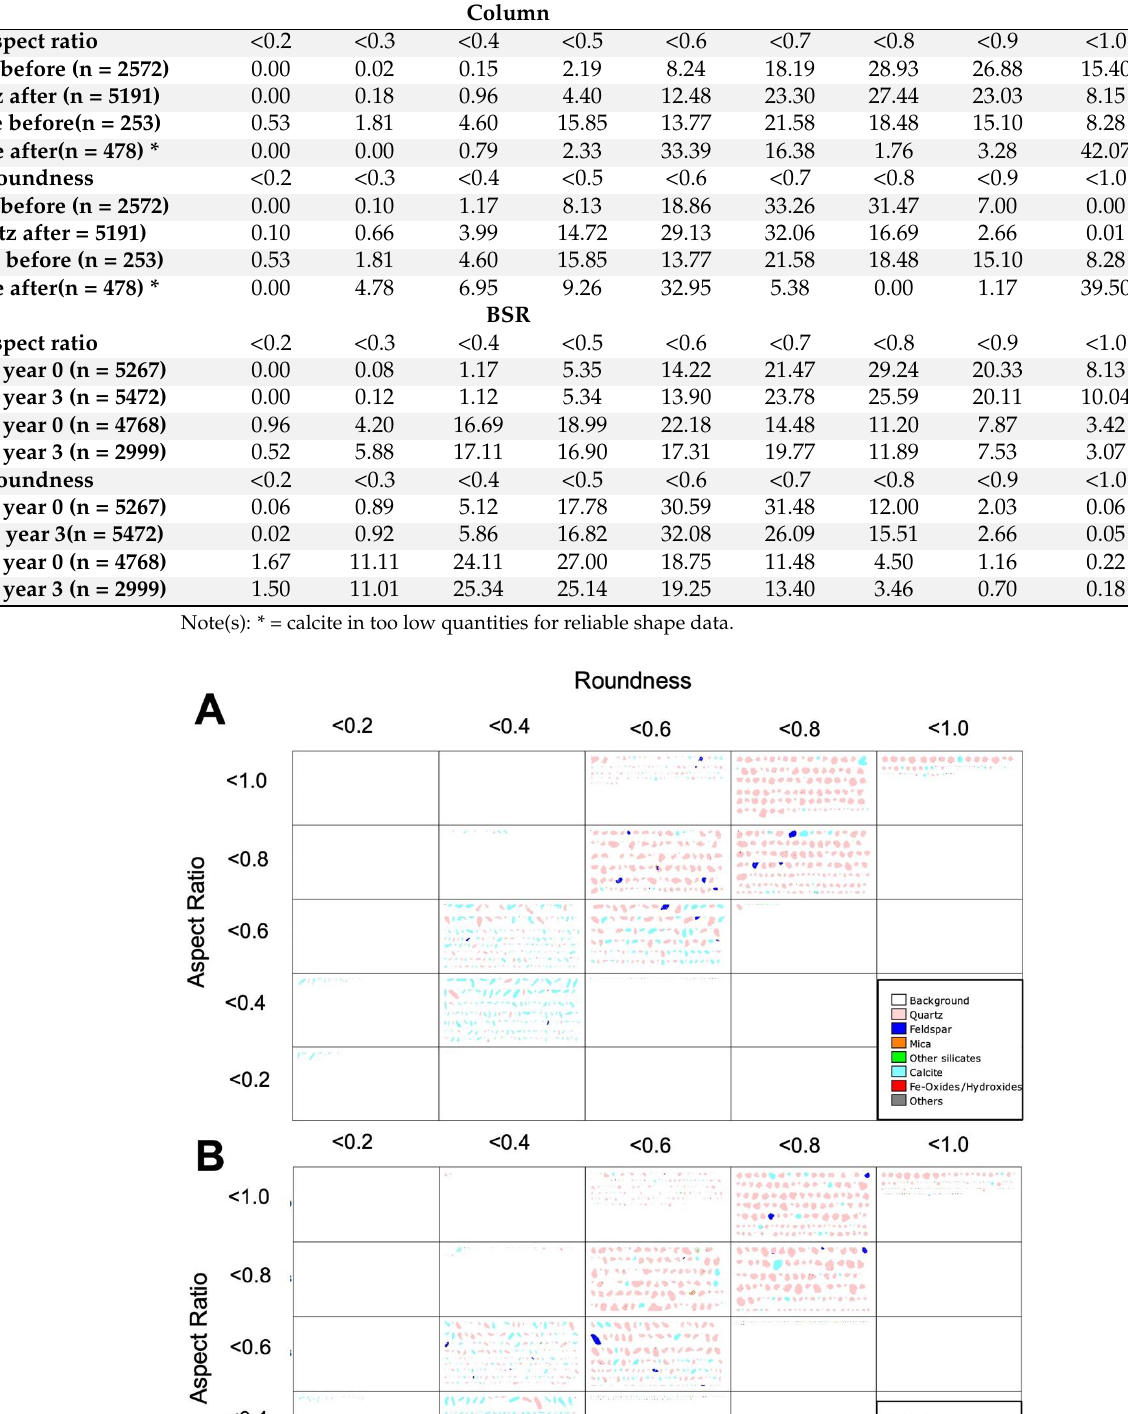
Table 5. Relationship of mass % distribution of quartz and calcite particles in terms of aspect ratio and roundness. Column